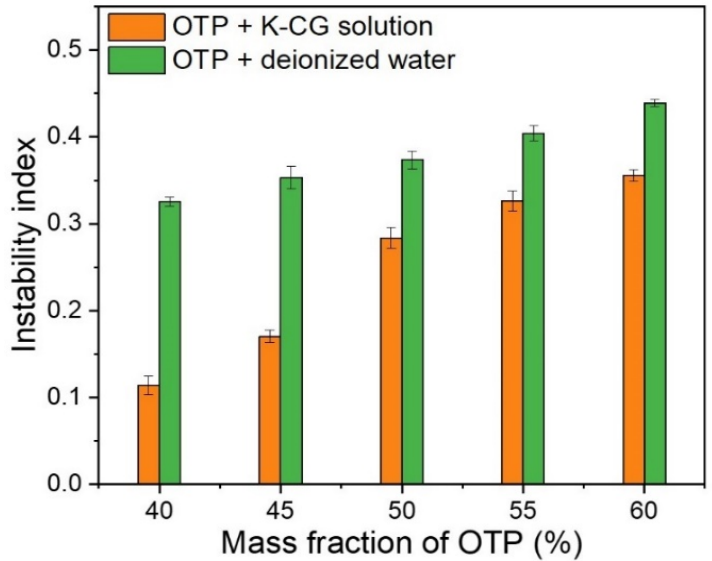
Figure 9. Instability index in dispersing OTP in water and K-CG solution.